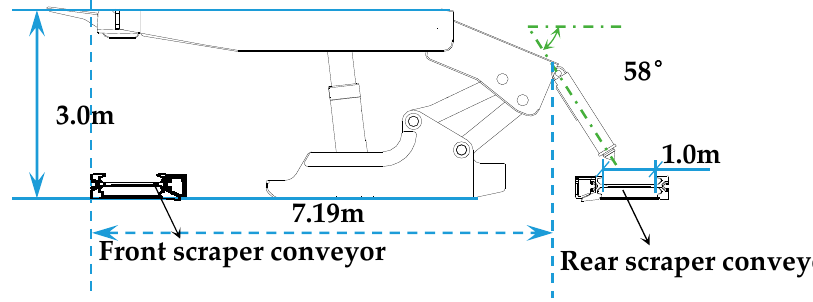
Figure 1. Hydraulic support and scraper conveyors [31].